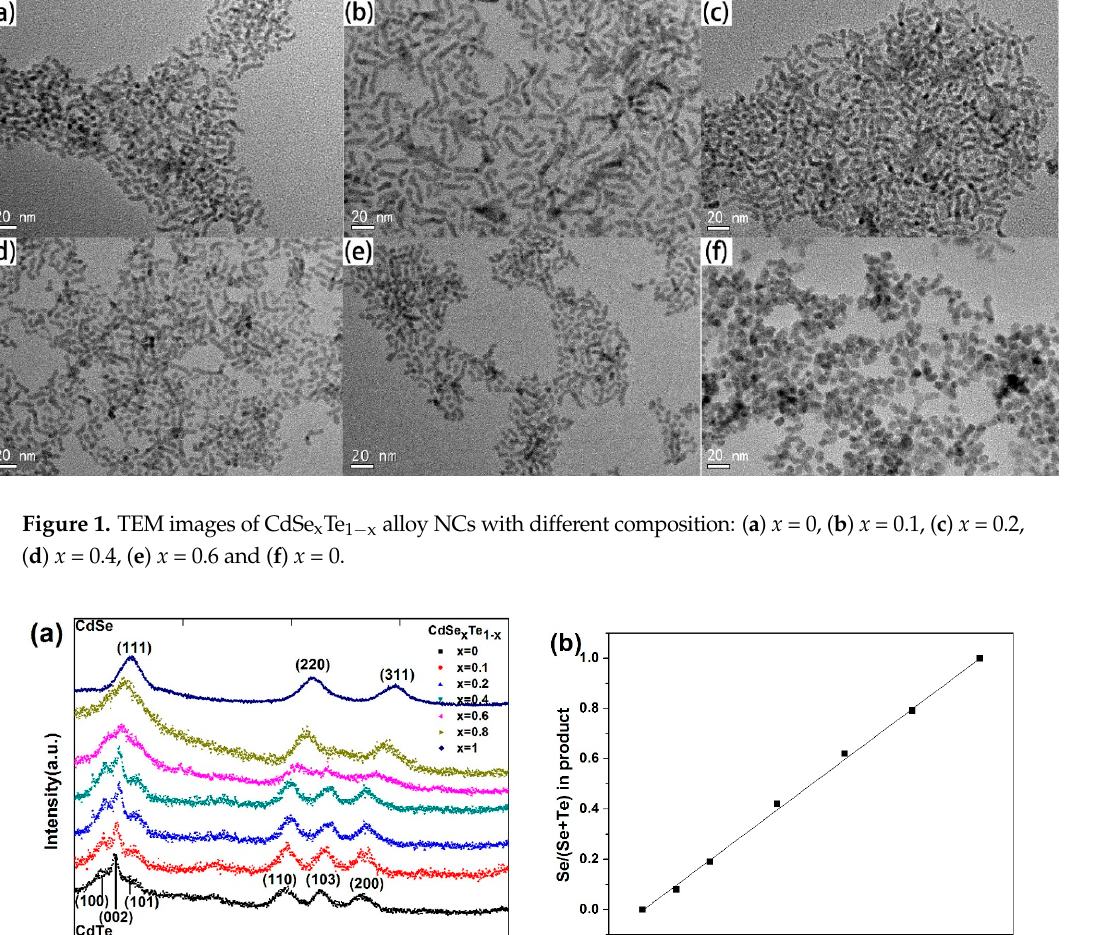
Figure 2. ( a ) The XRD pattern of the CdSe x Te 1 − x NCs with different composition and ( b ) the EDS results for CdSe x Te 1 − x NCs with different composition.